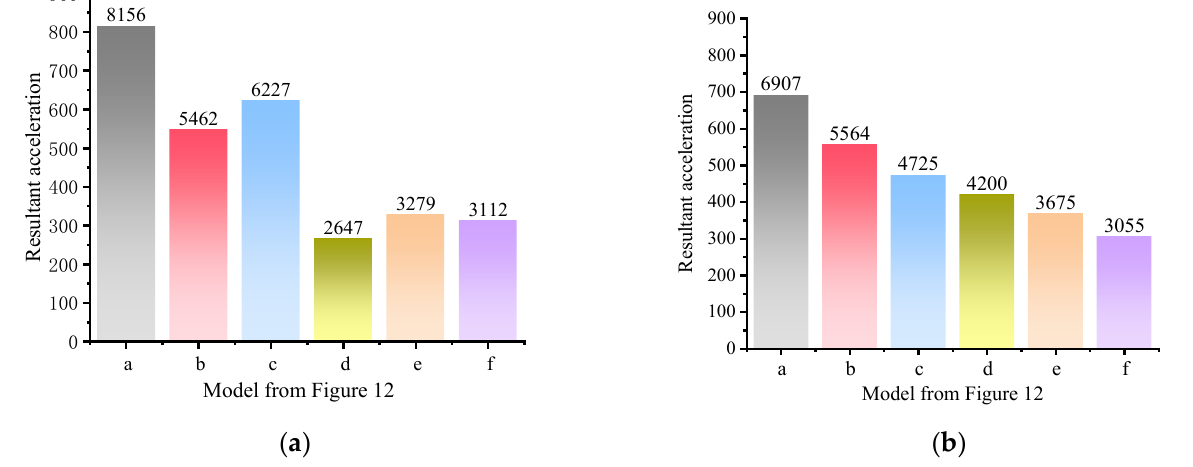
Figure 16. Resultant acceleration at the hance ( a ) inner side of the hance ( b ) outer side of the